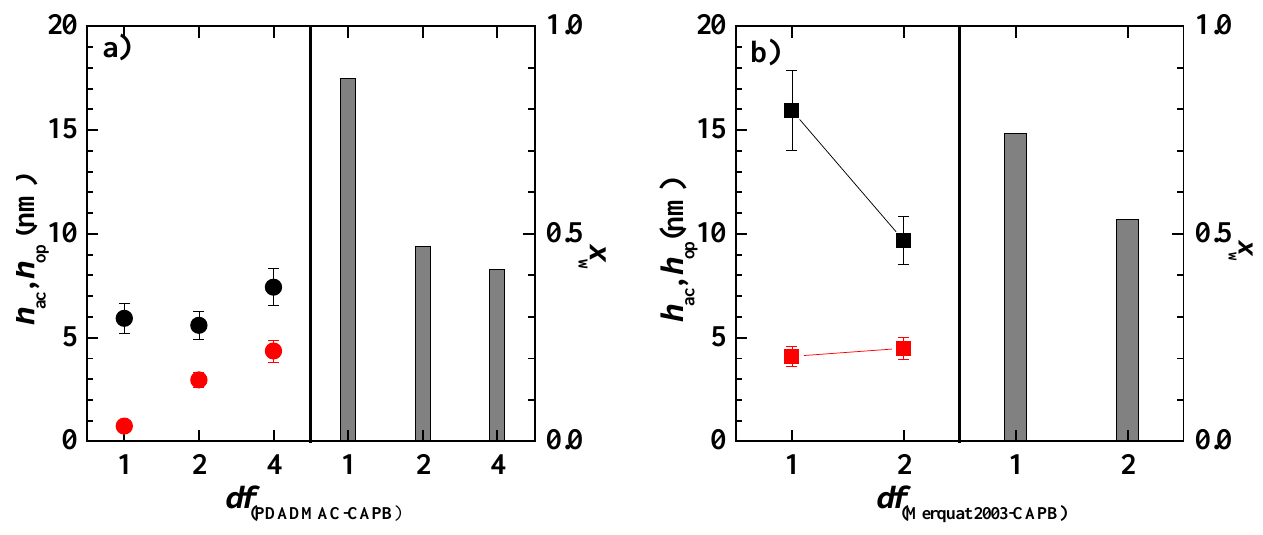
Figure 7. Comparison of the a coustic (● and ■ ) and optical ( ● and ■ ) thickness for the deposition of polymer–CAPB layers, and water content of the deposited layers (bar charts), for samples at different values of the dilution factor. ( a ) Mixtures with PDADMAC. ( b ) Mixtures with Merquat 2003.